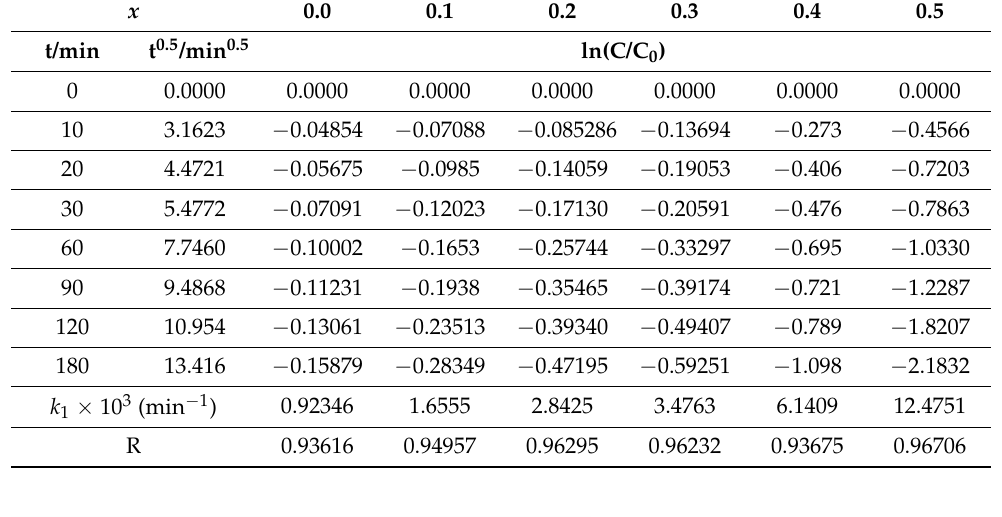
Table 3. Photocatalytic properties of (Mn 0.5 Zn 0.5 )[Cd x Fe 2- x ]O 4 (x ≤ 0.05) NSFs.